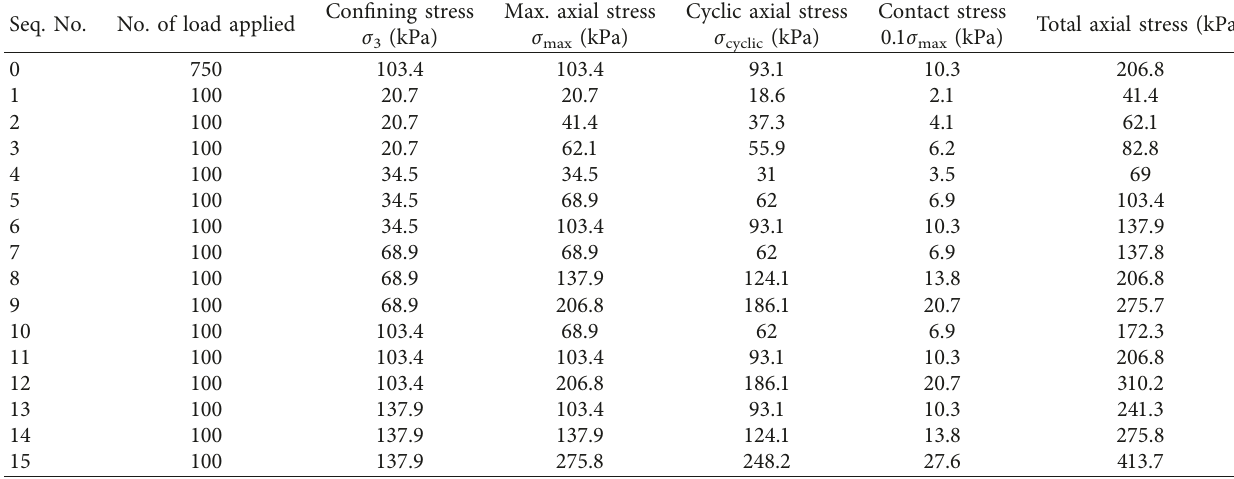
Table 4: Loading sequence for the resilient modulus test as per AASHTO T 307 protocol. Seq. No.